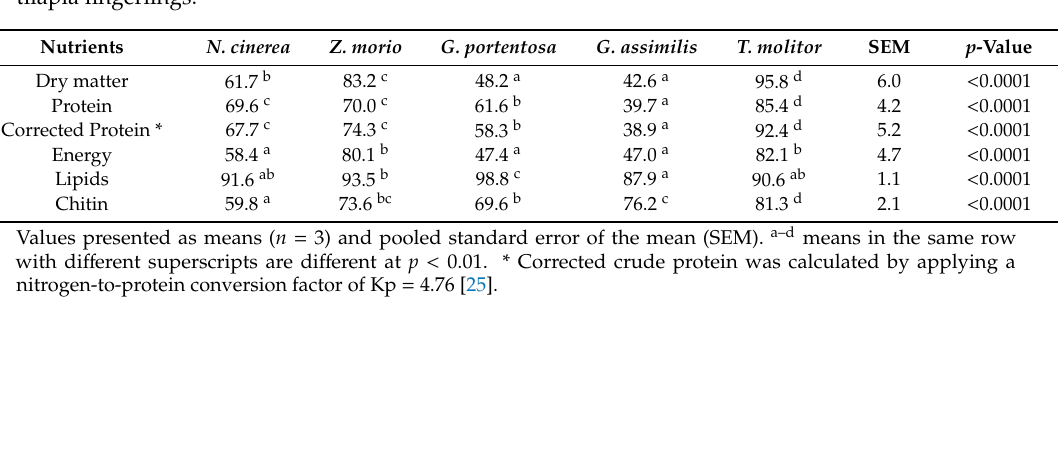
Table 3. Apparent digestibility coe ffi cients (%) of the five insect meals evaluated for Nile tilapia